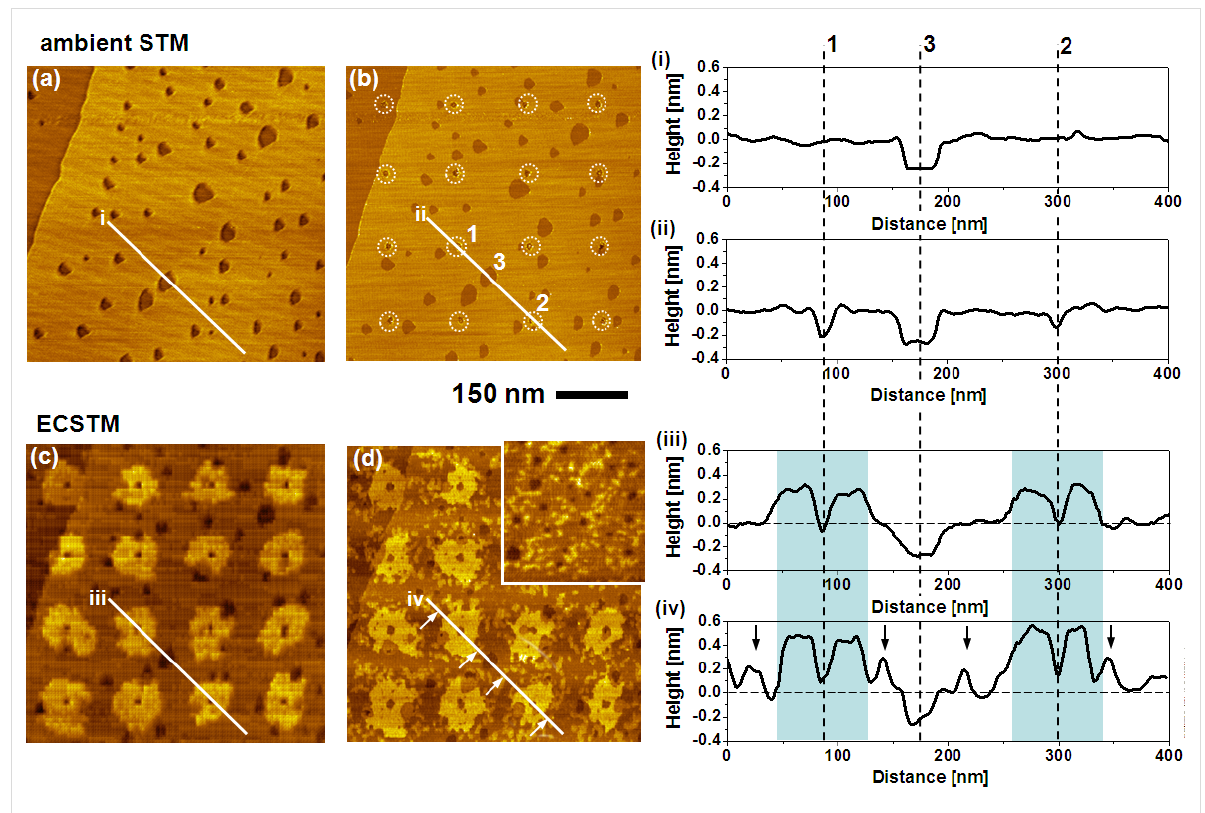
Figure 5: Sequence of STM images showing the UPD-based conversion of a BP2 SAM into a patterned binary SAM of BP2 and AdSH. Left: (a) Native BP2 SAM. b) Array of defects (encircled) created by STM lithography while using voltage pulses of 3.5 V and 50 ms duration. (c) Pattern of Cu-UPD generated by holding the sample potential at +0.3 V vs Cu 2+ /Cu for 10 seconds. (d) Binary SAM structure after reductive desorption of BP2 and adsorption of AdSH. The inset shows an area of the sample, which had not been modified by Cu-UPD. Right: Compilation of height profiles along lines shown in the STM images illustrating the evolution of topography. Protrusions marked by arrows in (iv) reflect AdSH covered Au islands. For details see